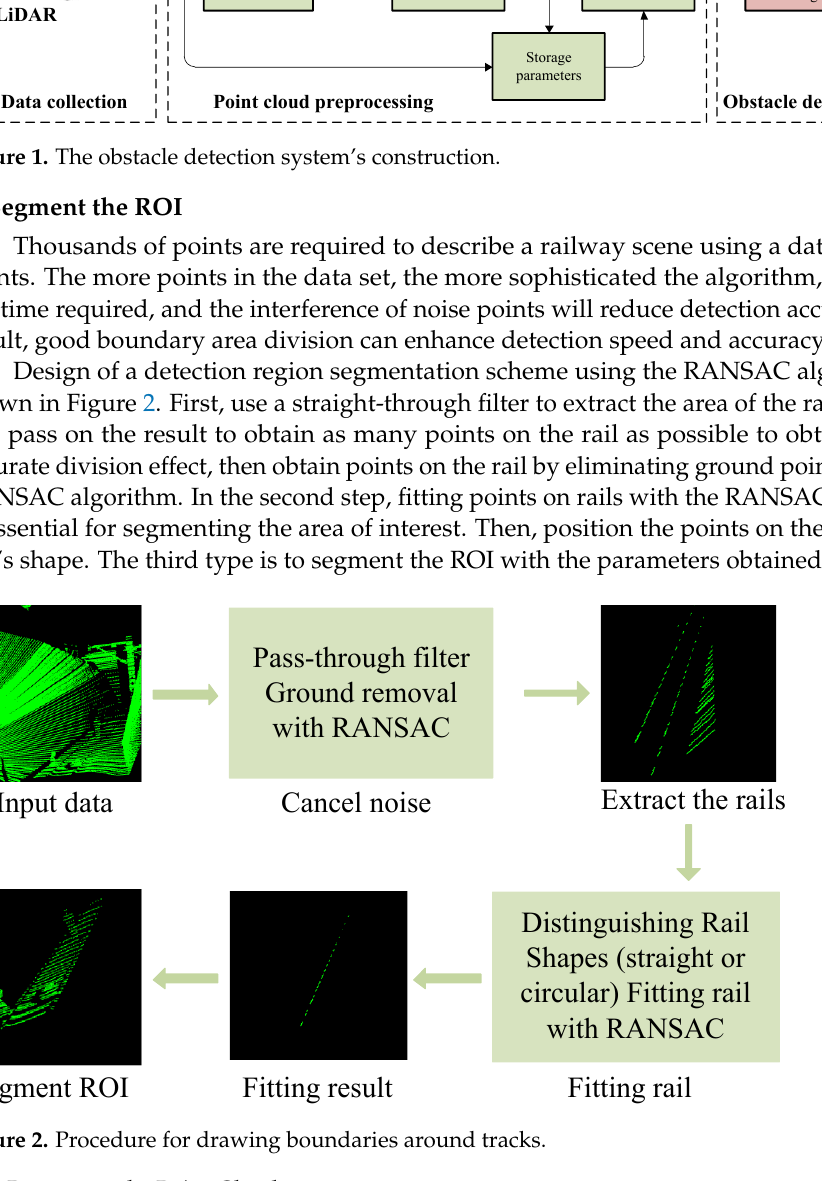
Figure 1. The obstacle detection system’s construction.